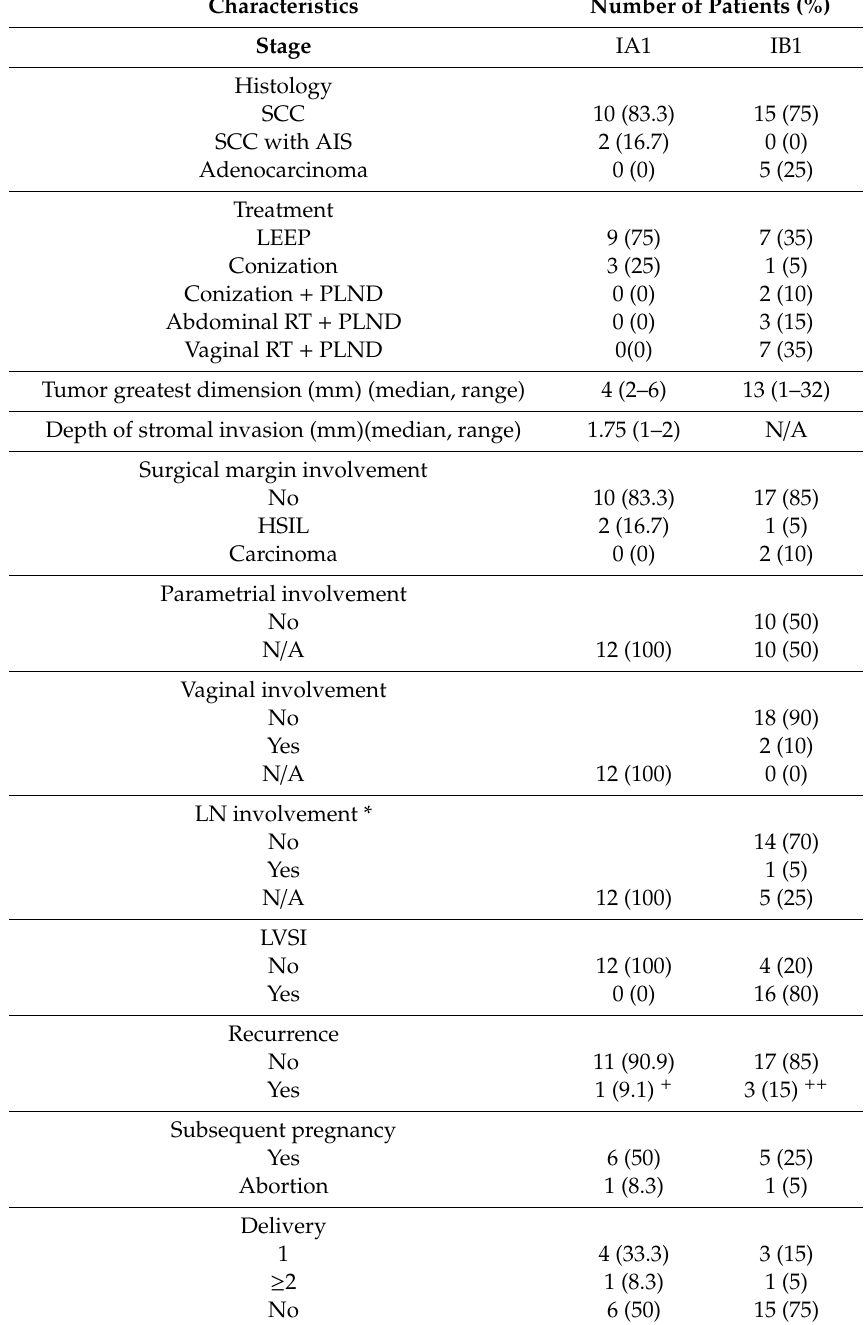
Table 2. Characteristics of 12 stage IA1 and 20 stage IB1 invasive cervical cancer patients treated with fertility-sparing